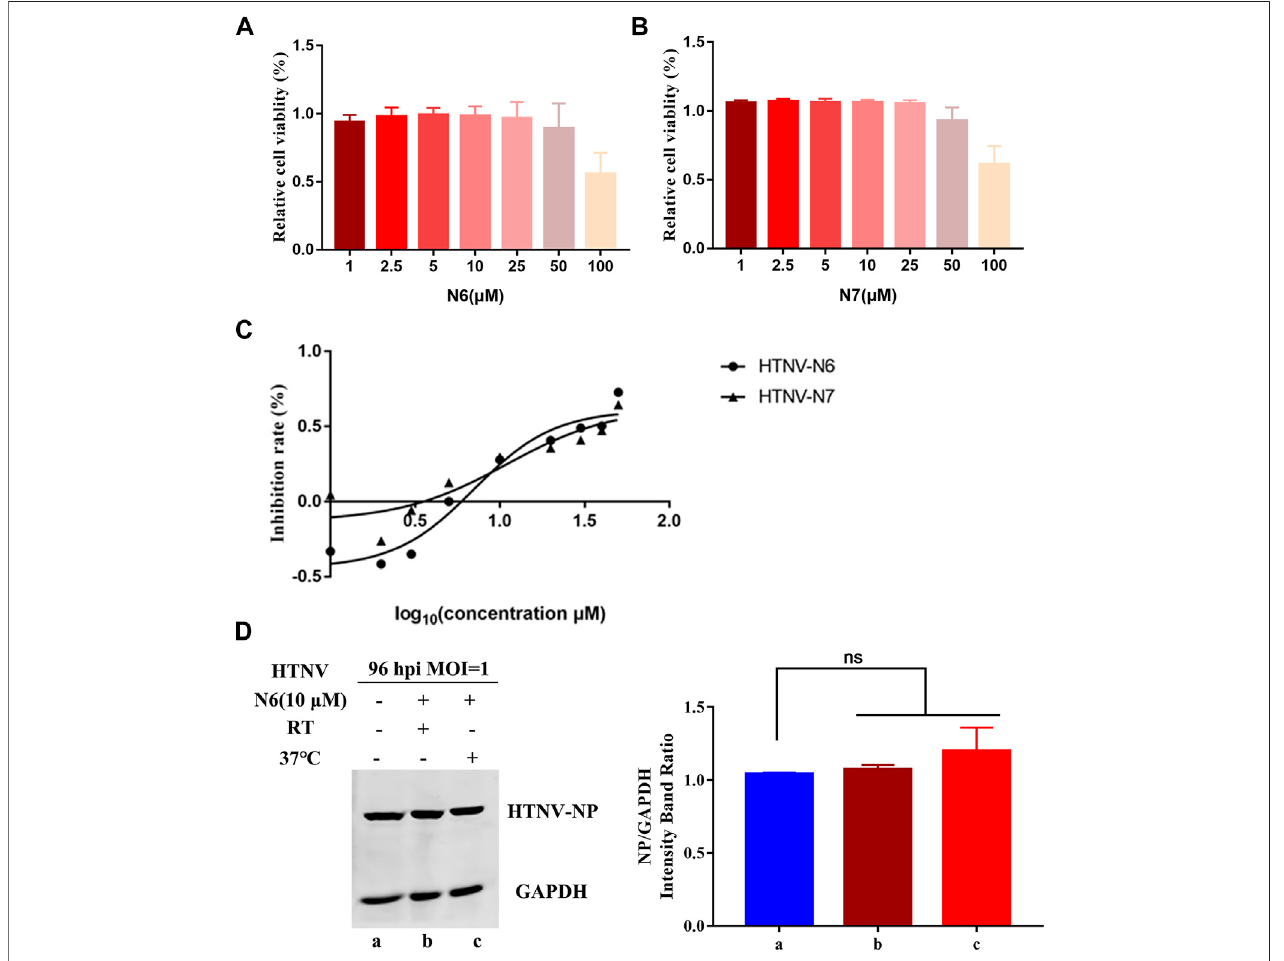
FIGURE 2 | N6 inhibits HTNV without direct virucidal activity (A) The cytotoxicity assay showed that the survive rate of A549 cells treated by N6 ranging from 1 to 100 μ M was more than 80%, and CC50 of N6 was 77.08 ± 0.56 μ M (B) N7 inhibited the proliferation of A549 cells with CC50 at 64.78 ± 0.53 μ M (C) N6 and N7 displayed an anti-HTNV activity in a dose-dependent manner with EC50 at 7.06 ± 1.05 μ M and 11 ± 0.76 μ M, respectively (D) Western blot assay showed that pretreatmentof10 μ MN6couldnotaffectHTNVinfectivityat96hpiatroom temperature (laneb)or37 ° C(lanec).Resultsofthestatisticalanalysesaredepictedas follows: Student ’ s t test or one-way ANOVA; ns, p > 0.05, n (cid:2)